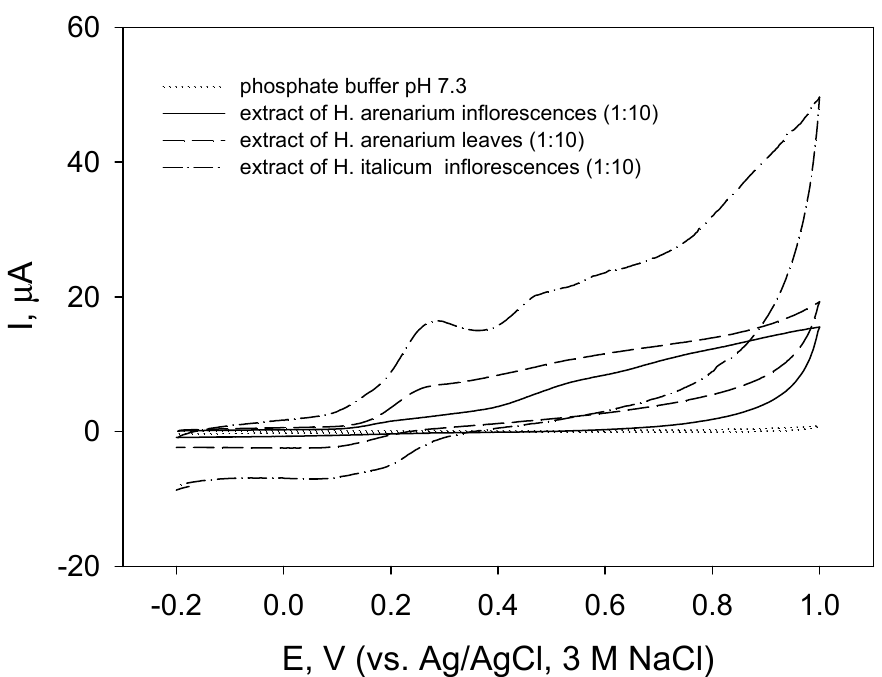
Figure 1. Cyclic voltammograms of carbon paste electrodes in extracts inflorescences and leaves of H. arenarium and inflorescences of H. italicum (as indicated) in phosphate buffer pH 7.3, potential scan rate 100 mV/s.